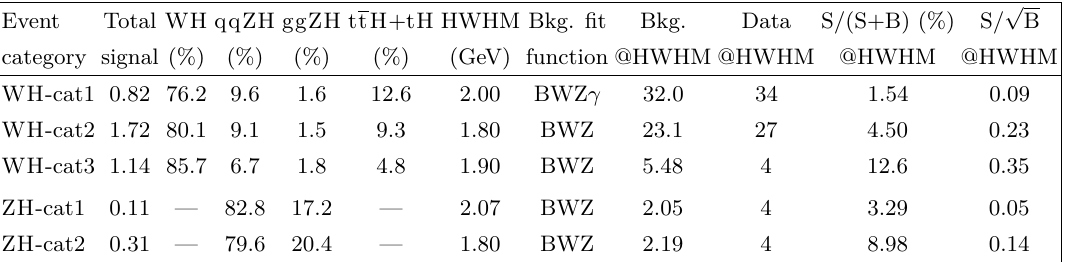
Table 8 . The total expected number of signal events with m = 125 . 38 GeV (S), the ratio of the H expected contributions from different production modes to the total signal yield, the HWHM of the signal peak, the functional form used for the background modelling, the estimated number of background events (S) and the observed number of events within ± HWHM , and the S/(S+B) and √ the S / B ratios computed within the HWHM of the signal peak for each of the optimized event categories defined along the WH and ZH BDT